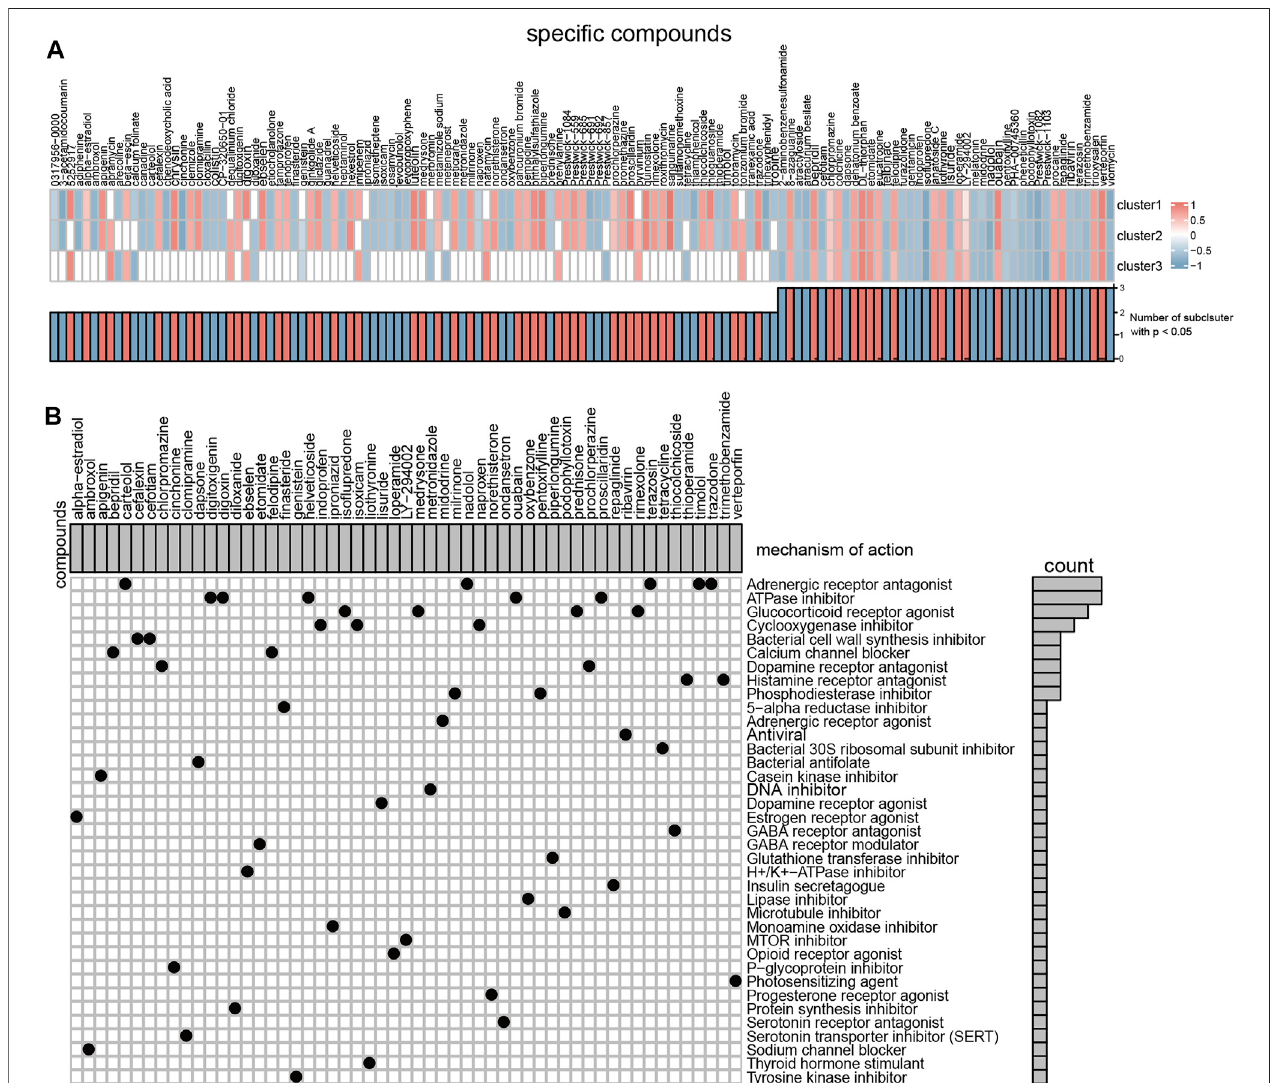
FIGURE 9 | Connectivity Map tools predict the small molecules compounds target different severe OSA subclusters. (A) Heatmap showing enrichment score (positive in blue, negative in red) of each compound from the CMap for each OSA subtypes. (B) Heatmap showing each compound (perturbagen) from the CMap that shares mechanisms of action (rows) and sorted by descending number of compounds with shared mechanisms of